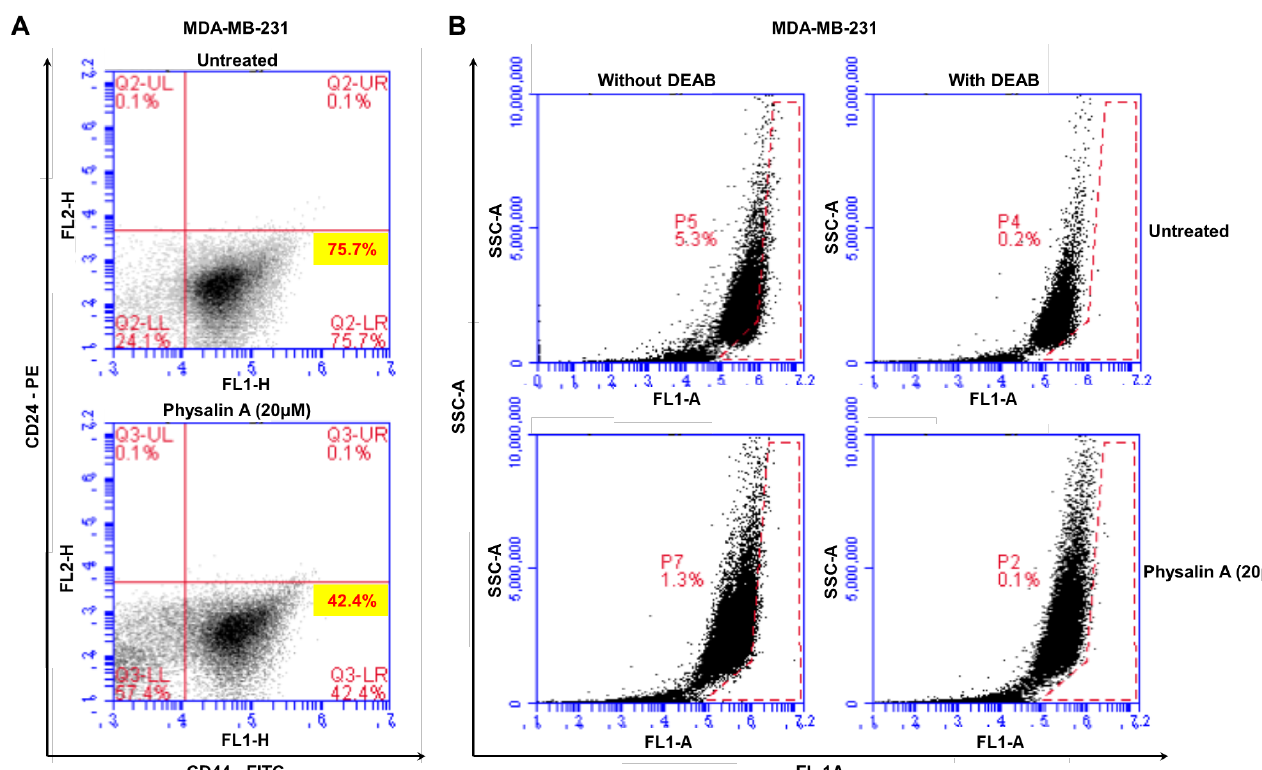
Figure 2. Effects of physalin A in CD44 high /CD24 low and ALDH1-expressing breast cancer cells. CD44 high /CD24 low -cell sub- population was measured by flow cytometry after treatment with physalin A (20 µM). ( A ) Effects of physalin A on CD44 high /CD24 low -expressing breast cancer cells. 1 × 10 6 cells were cultured for 1 day and then treated with physalin A. After 1 day, cells were incubated with FITC-CD44 and PE-CD24 (BD, San Diego, CA, USA) and placed on ice for 20 min. Breast cancer cells were washed twice with 1X FACS buffer and assayed using flow cytometry (Accuri C6). The red cross was based on the binding of an antibody without physalin A. ( B ) MDA-MB-231 breast cancer cells were also treated with physalin A for 1 day. ALDH assay was performed using the ALDEFLUOR kit (StemCell Technologies). Breast cancer cells were incubated in ALDH assay buffer at 37 °C for 20 min. ALDH1-positive cells were determined using flow cytometry (Accuri C6).